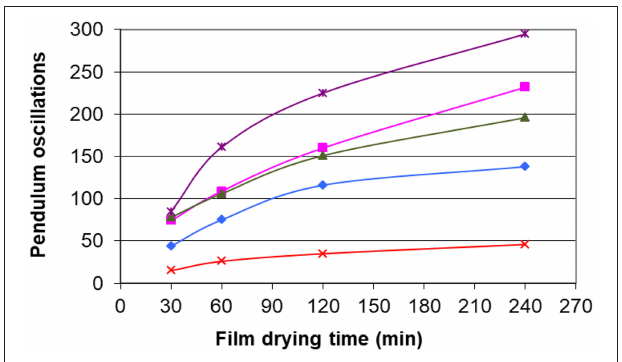
FIGURE 10 | Effect of the plasticizers on the Persoz hardness. no plasticizer, diisoamyl carbonate, dilauryl carbonate, (cid:7) acetyl tributyl